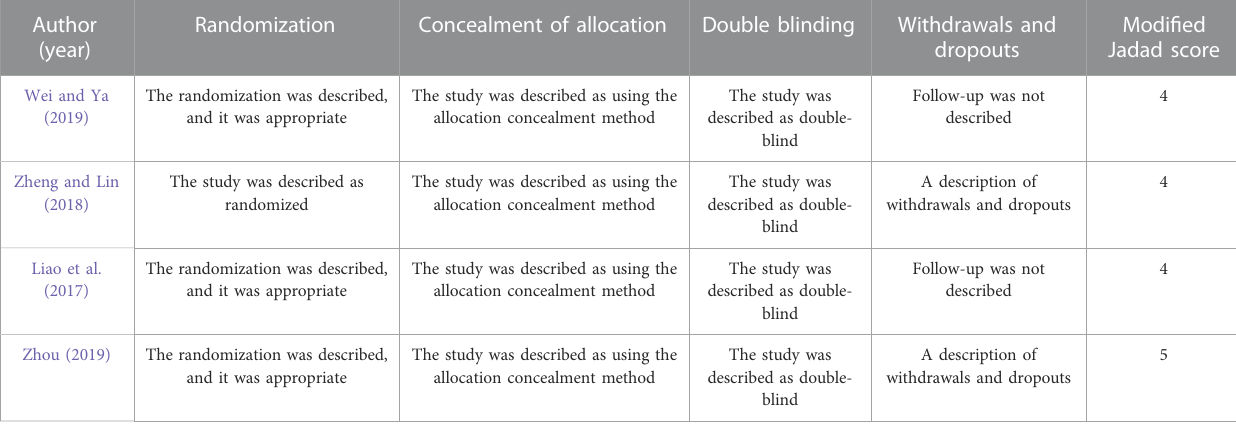
TABLE 2 Quality assessments of randomized controlled